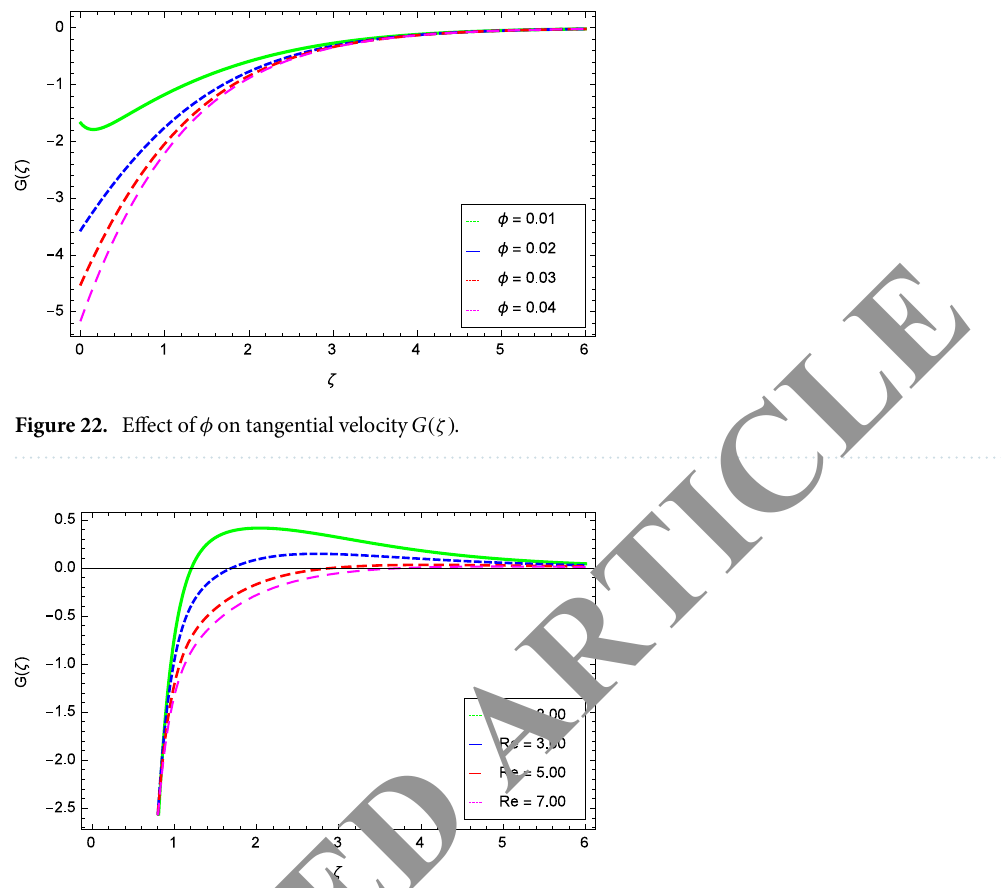
Figure 23. Effect of Re on tangential velocity G (ζ) .